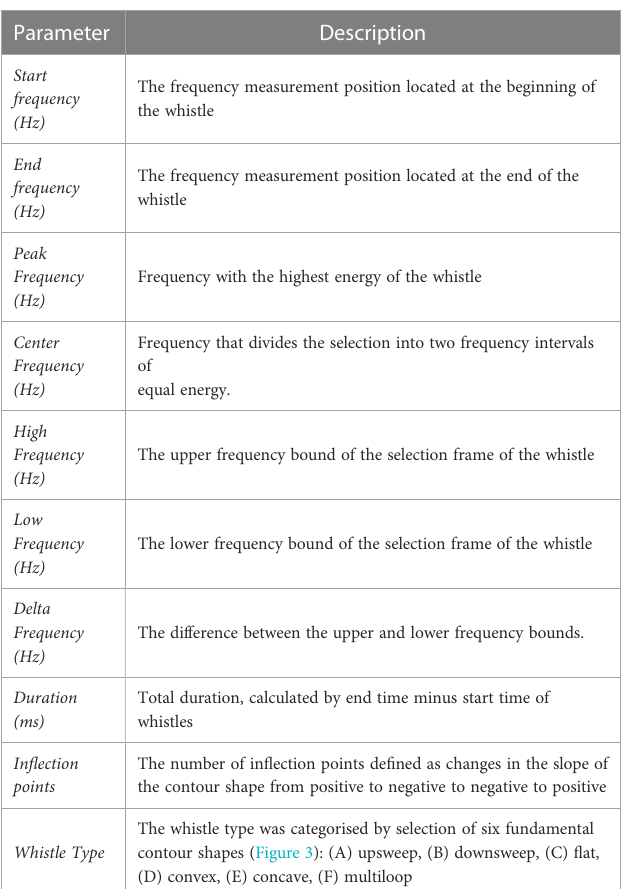
TABLE 1 Whistle parameters measured manually within spectrograms using Raven Pro 1.6.